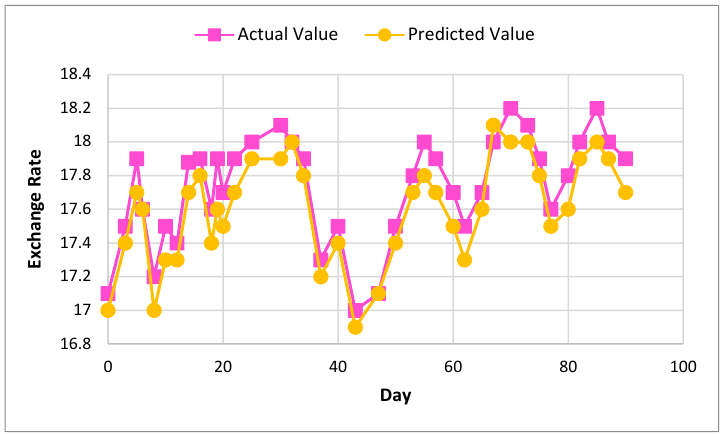
Figure 11. Actual and predicted value of Monero using XGBoost for 90